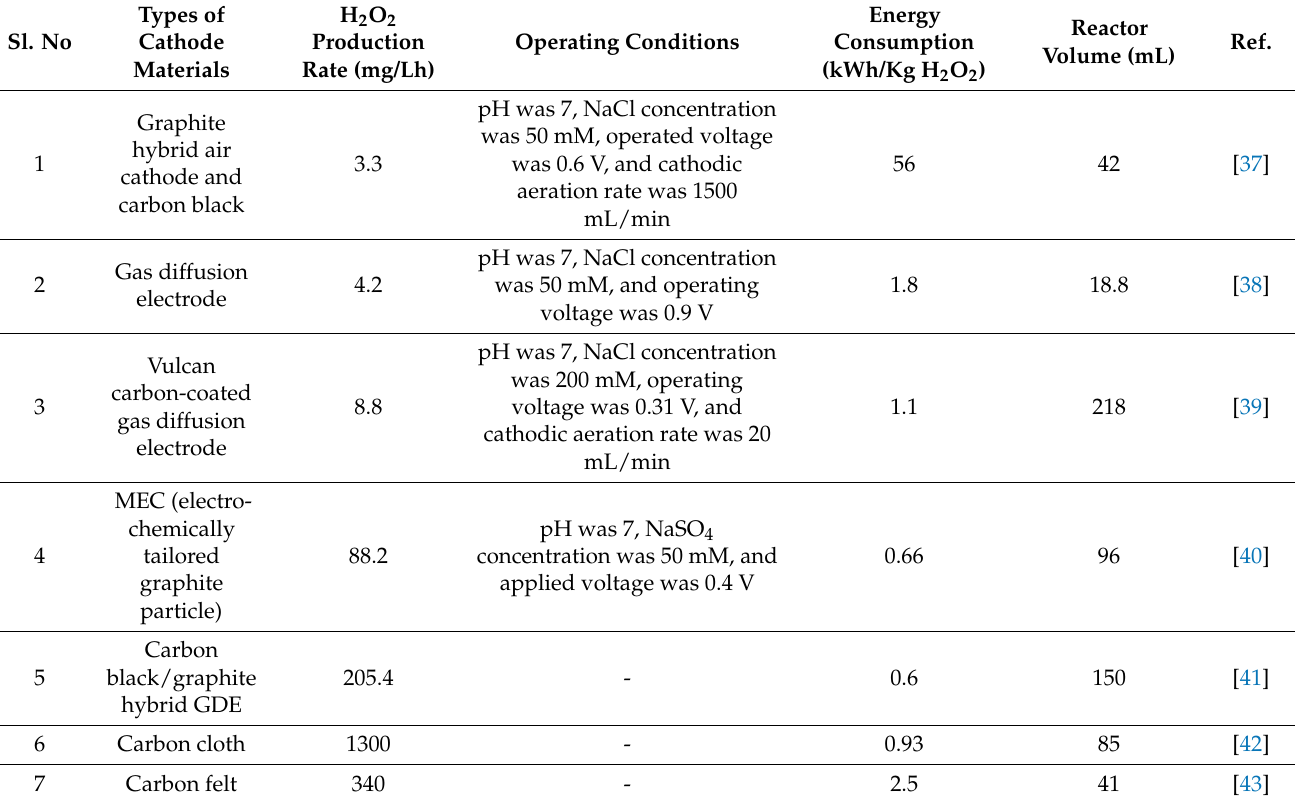
Table 1. The details of different studies performed on hydrogen